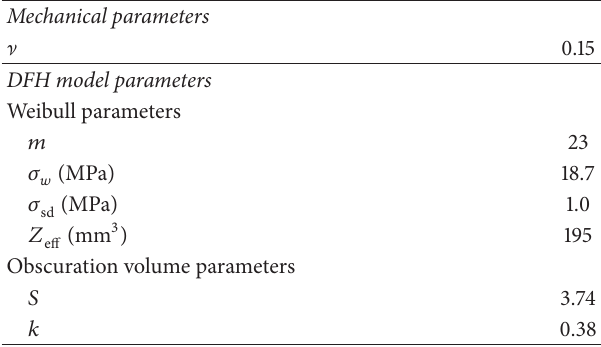
Table 1: Material parameters used in the DFH material